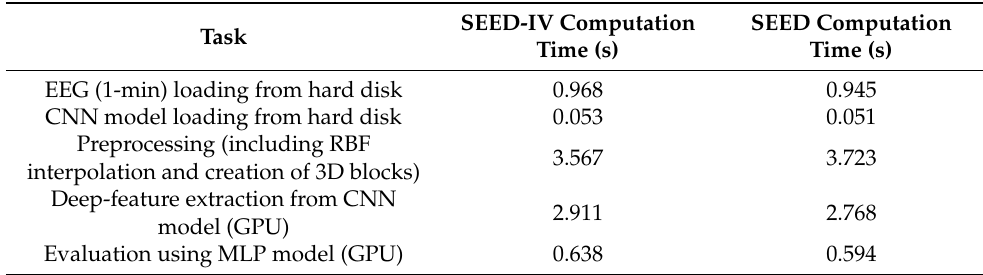
Table 10. Computation time in seconds for evaluating 1 min of 62-channel EEG recording at 200 Hz sampling